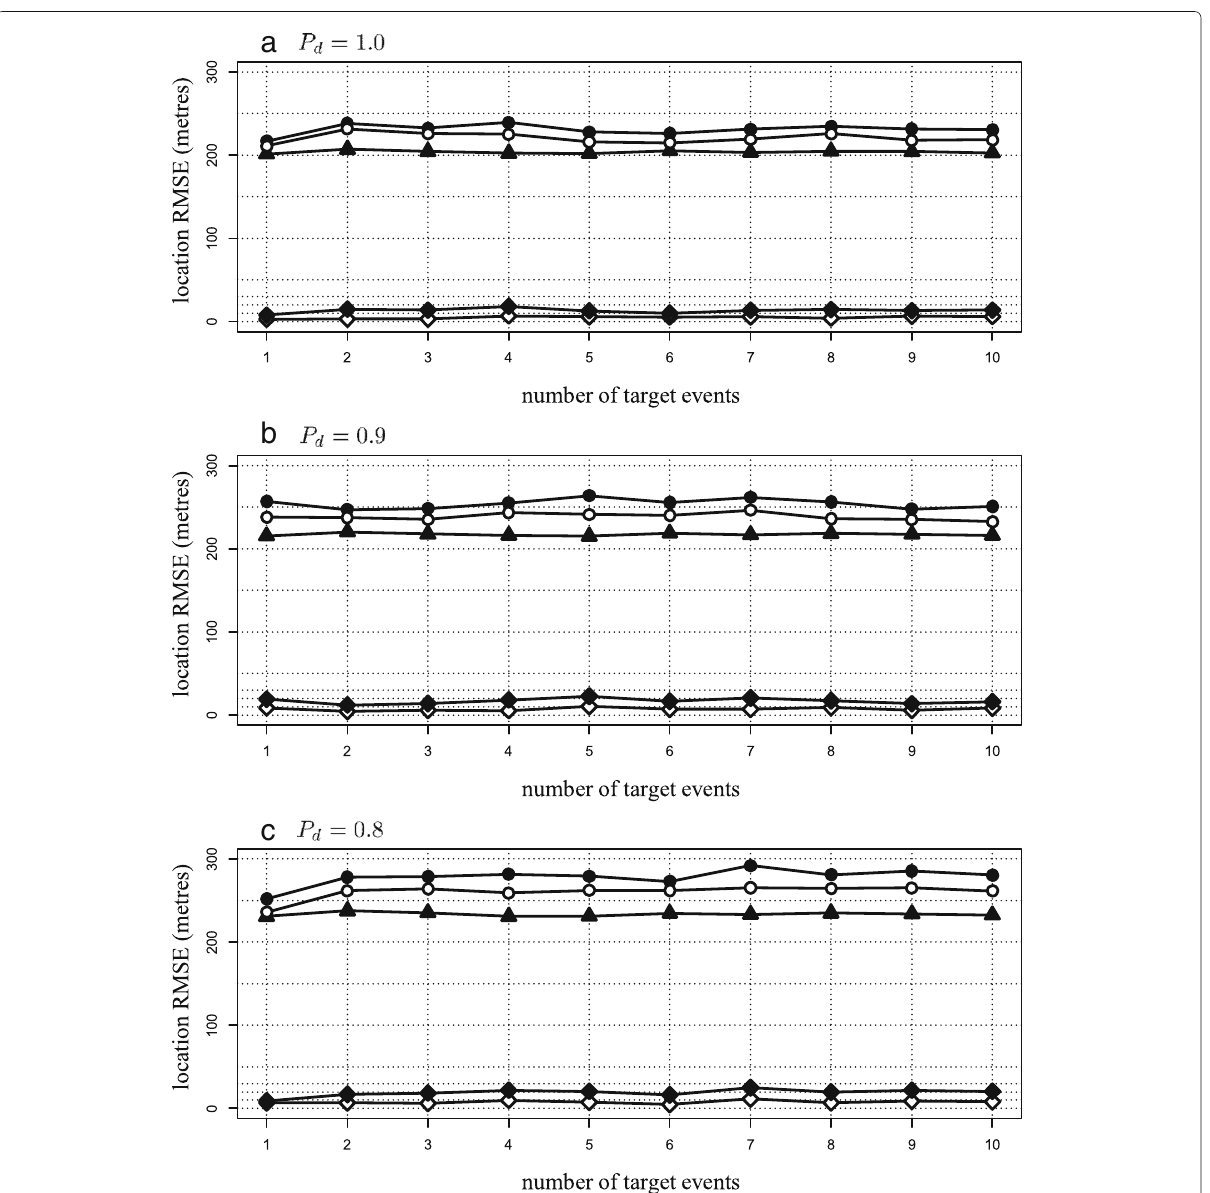
Fig. 4 Target localisation performance for scenario 1. The TALA RMSE ( blackcircles ), gTALA RMSE ( whitecircles ), and the CRLB RMSE ( blacktriangles ). The percentage differences between the performance of the TALA and ( i ) the CRLB ( blackdiamonds ) and ( ii ) the gTALA ( whitediamonds ). Results are averaged over all 1000 simulations. a P d = 1.0. b P d = 0.9. c P d =